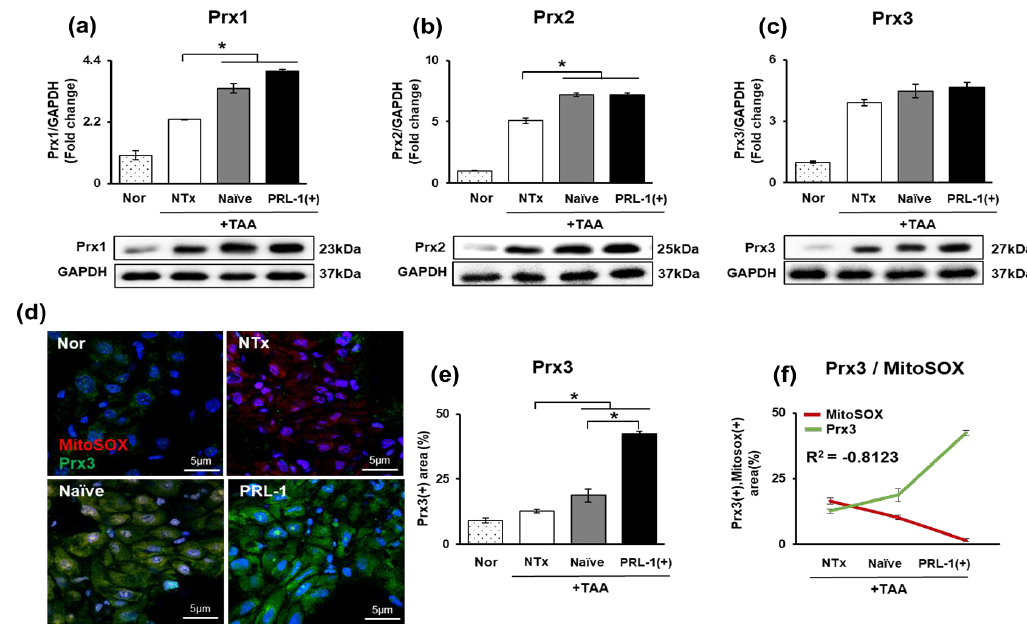
Figure 4. Peroxiredoxin family in naïve and PRL-1(+) cell-transplanted rat livers. The expression of the peroxiredoxin family in TAA-injured rat liver by Western blot and IF ( a ) Prx1, ( b ) Prx2, ( c ) Prx3, ( d ) MitoSOX and Prx3, ( e ) Prx3 intensity, ( f ) Prx3 and MitoSOX graph. All experiments were repeated in duplicate to triplicate. * p < 0.05.